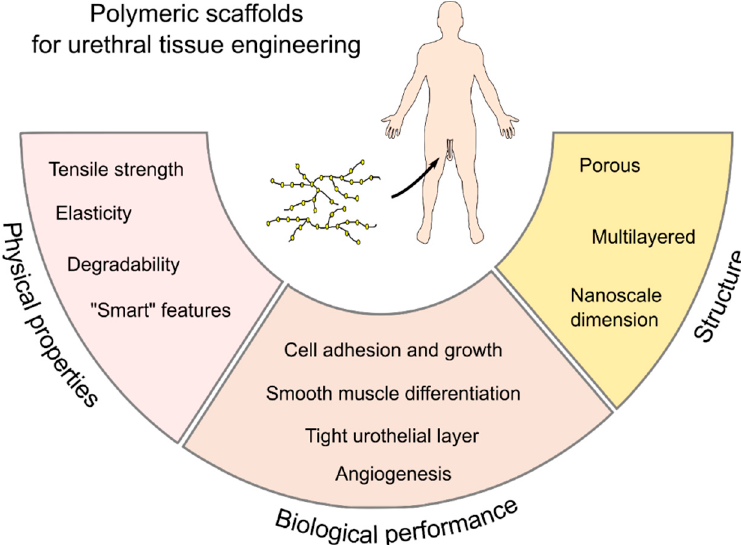
Figure 6. Desirable properties of polymeric scaffolds for urethral tissue engineering. These design constraints appear to be fundamental to better resemble the physical, biological, and structural properties of the native urethra and are expected to support an adequate recovery of the urethral function.